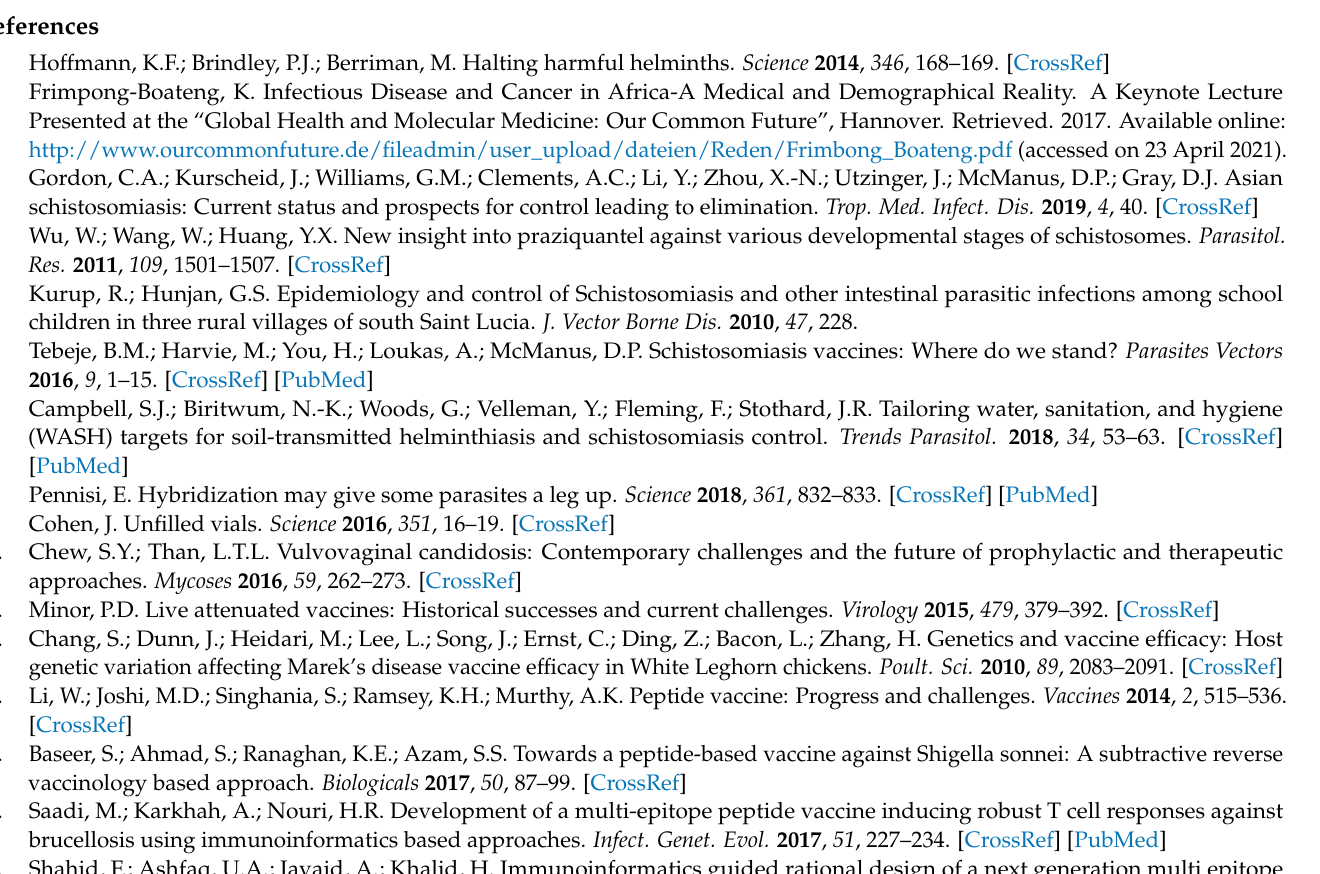
Table S2: HTL Epitopes predicted by the IEDB Consensus Method. Table S3: LBL Epitopes predicted Table S5: Linear B cell epitopes predicted in the vaccine by the ABCPred